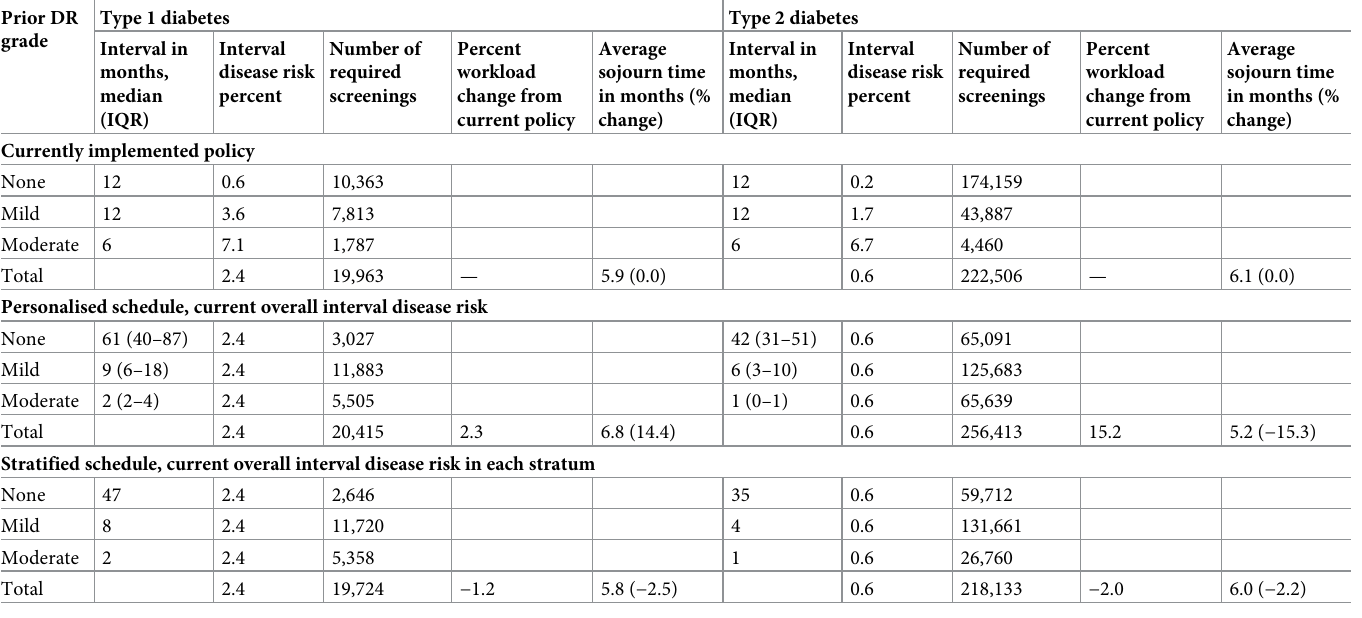
Table 3. Workload and sojourn time effects of setting screening intervals to equalise stratum-specific or personal risks of referable disease at the current interval disease